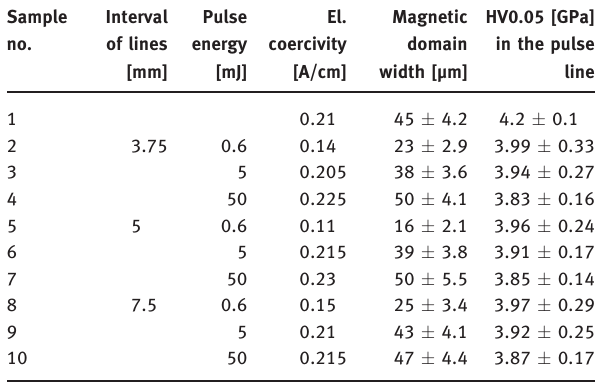
Table 2: Mechanical and electro-magnetic properties of the Fe-3.2% Si silicon steel. Sample